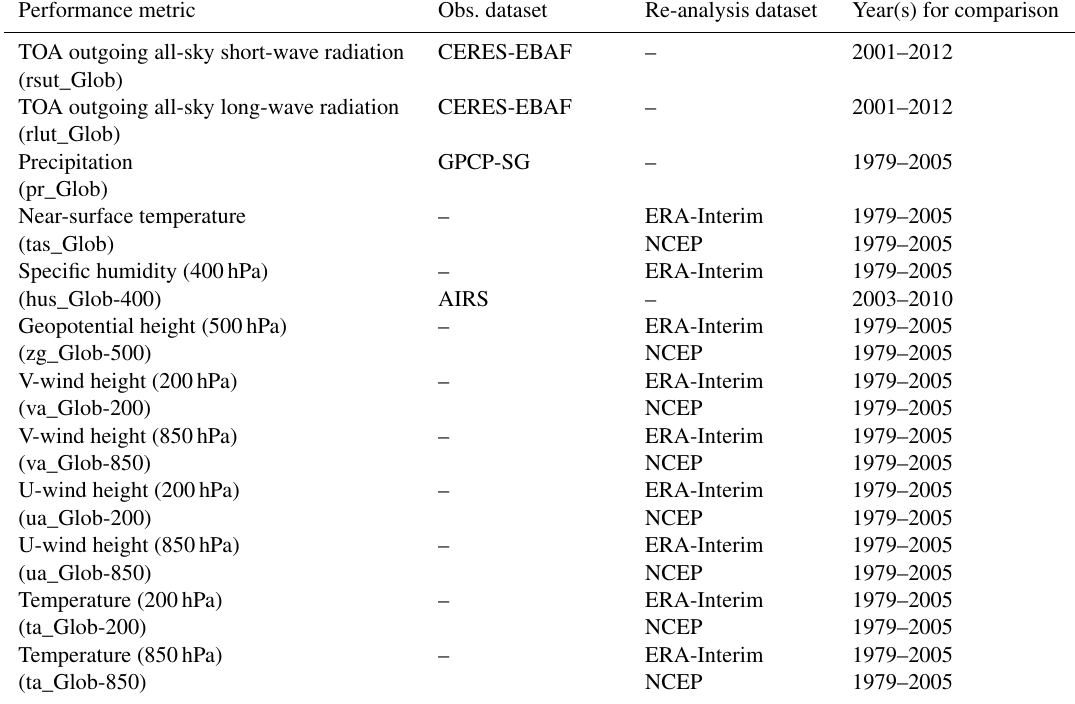
Table 4. Observational and reanalysis datasets used for the evaluation in Fig. 2. Performance metric Obs.